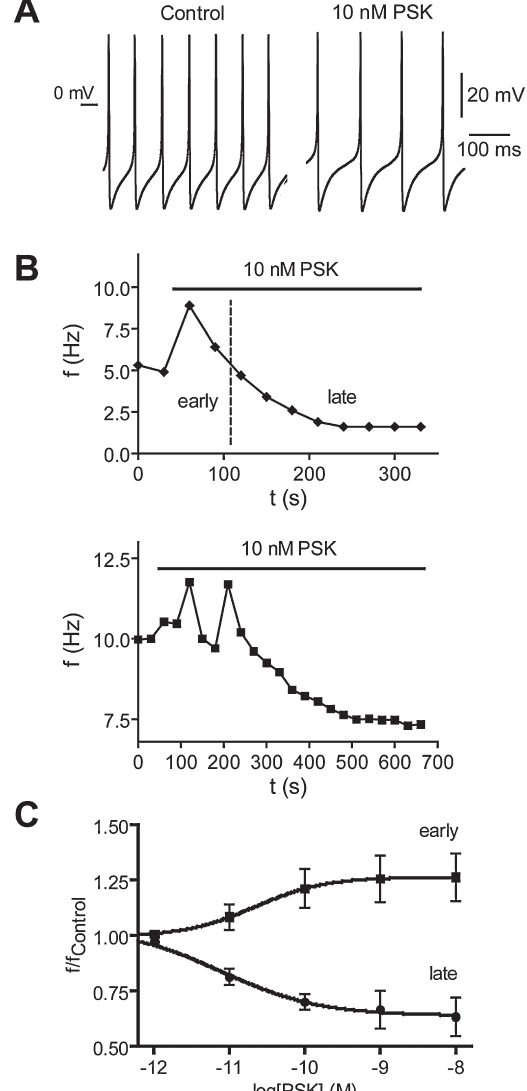
Figure 6. Effect of PSK on spiking of isolated DUM neurons of the sixth abdominal ganglion of Periplaneta. ( A ) Spike trains recorded under current- clamp conditions (no current injected) before and 4minutes after application of 10nM PSK. ( B ) Time courses of the biphasic PSK effect on spike frequency f for two different neurons. An early response is characterized by an accel- eration of spiking (upper panel) which may involve oscillations in frequency (lower panel). In the late response the frequency decreases monotonously until reaching steady state. ( C ) Concentration dependence of early and late PSK effects on the normalized spike frequency. The early response curve contains frequency maxima recorded up to 3minutes after PSK application, the late response curve contains frequencies recorded at the end of PSK application where relaxation was complete. Data, means of 6–9 cells; bars, SEM. Dose- response curves fitted to data are described by EC 50 of 21 and 11pM as well as Hill coefficient of 0.94 and 0.72 for the early and the late response, respectively .